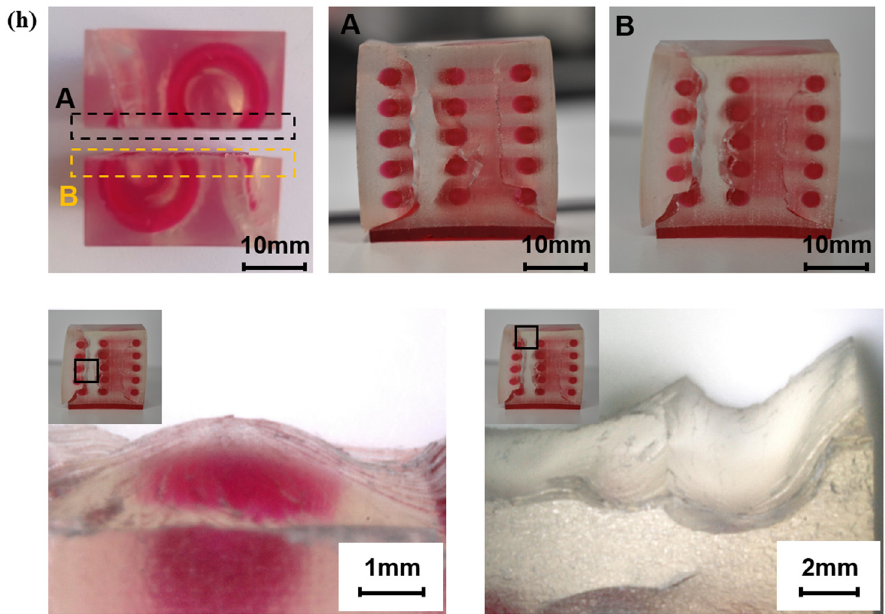
Figure 12. Stress-strain curves of different material designs, obtained from uniaxial compressive testings from ( a ) loading direction one (LD1); ( b ) loading direction two (LD2); ( c ) loading direction three (LD3). Comparisons of compressive stress-strain curves from three different loading directions for (d) design case one (pure horizontal/vertical first order); ( e ) design case two (pure horizontal/vertical second order); ( f ) design case three (mostly horizontal second order); ( g ) design case four (mostly vertical second order). ( h ) high resolution images (first row) and microscope images (bottom row) of case one, hybrid cube (pure horizontal/vertical first order) after compression from loading direction one. High resolution images show the cross-section A and B, from which cracks were found in the A30 matrix rather than A30/VMV interface. Microscope images show uneven fracture surfaces.